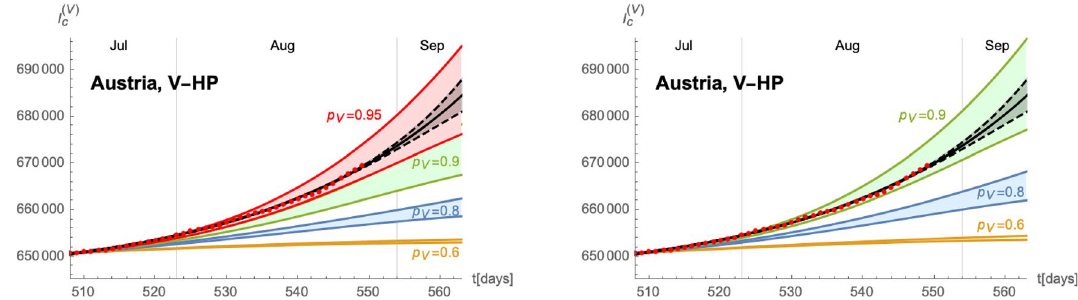
Figure 11. Predicted time evolution of the cumulative number of infected individuals for different values of the efficacy p V of the V-HP model. The left panel assumes p VT = 0.9 for the VT-HP currently in place in Austria and the right panel p VT = 0.8 . Both plots assume furthermore σ 2 /σ 1 = 1 and ρ = 0.0085